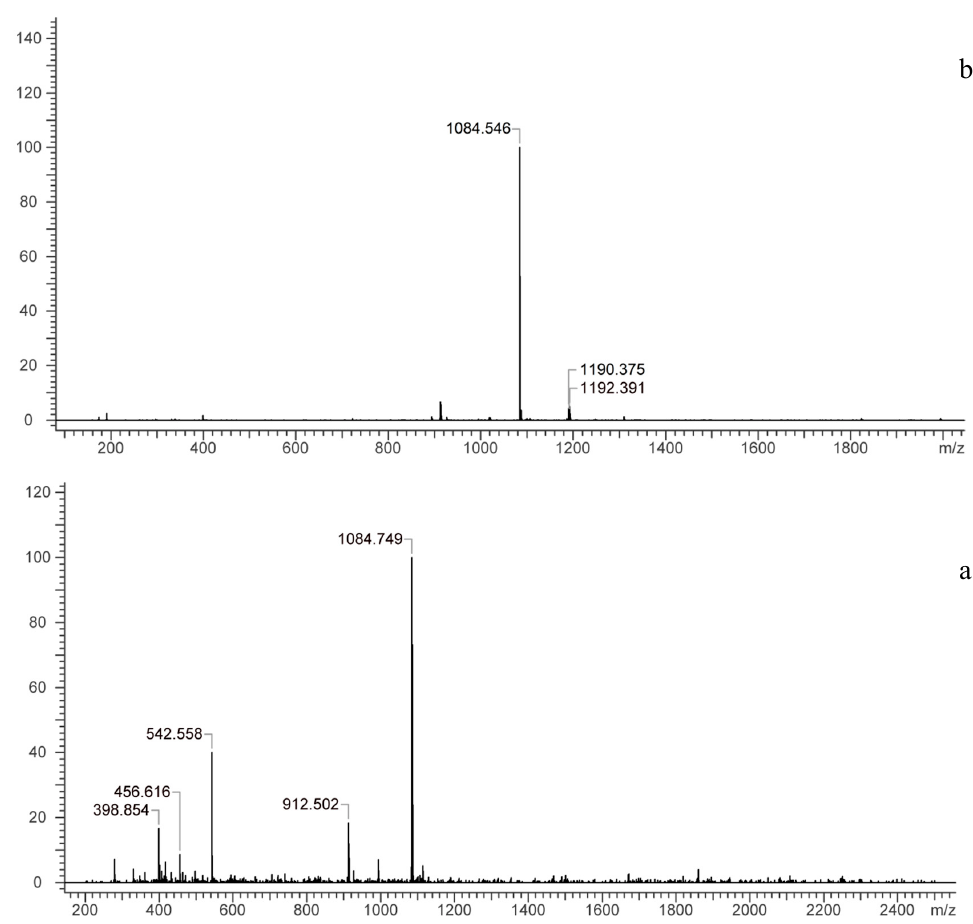
Figure 1. ESI-mass spectra for ligand L with AgNO 3 in acetonitrile ( a ) and methanol ( b ) .